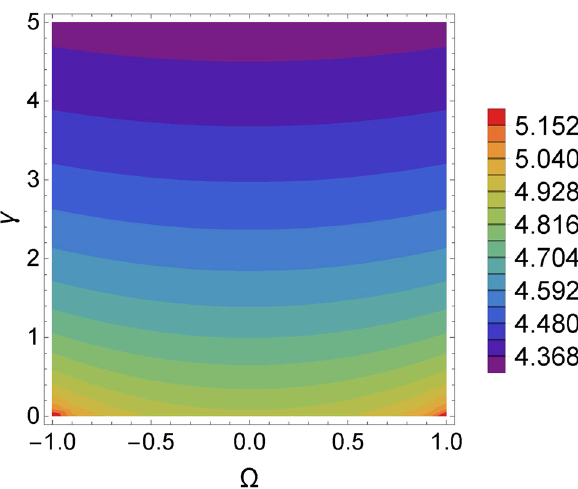
Fig. 8 The entropy S for T = 5 for the δ – δ (cid:2) comb, (56), in the param- eter space Ω − γ . We have chosen for the lattice spacing a = 1